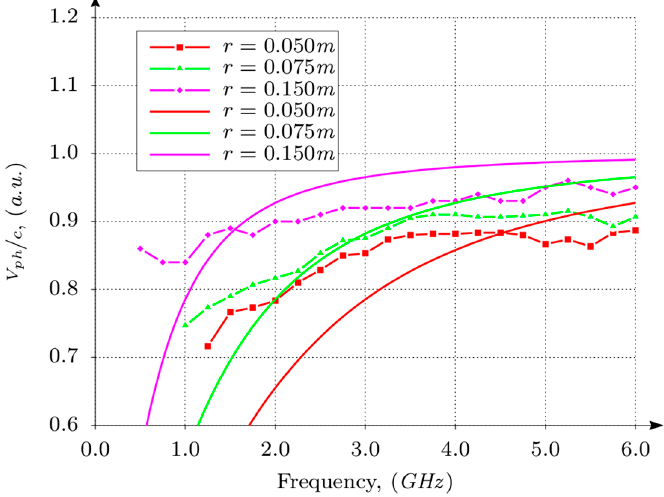
Figure 18. A comparison of the analytical model and full-wave simulations of creeping wave phase velocity.